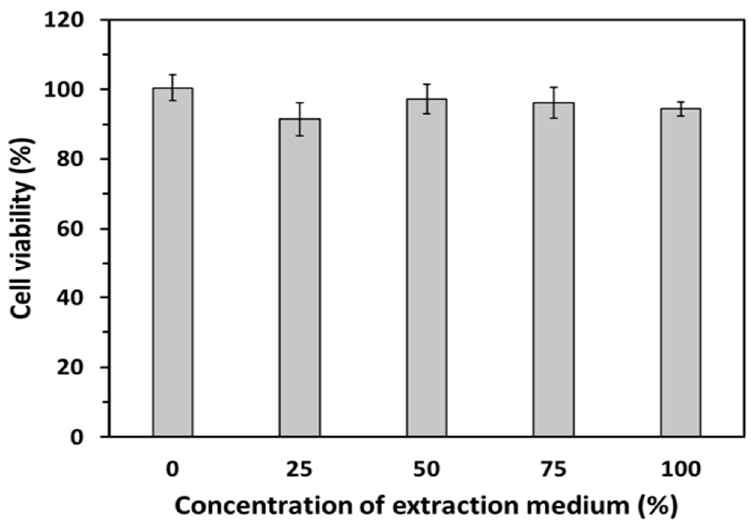
Figure 7. Cell viability of L929 fibroblasts were performed to examine the biocompatibility of GDES films which were incubated with various percentages (e.g., 25~100%) of extract medium from GDES films / incubated medium according to the ISO-10993-5. Accordingly, the GDES films were biocompatible. (Data are mean ± SD, n = 3).